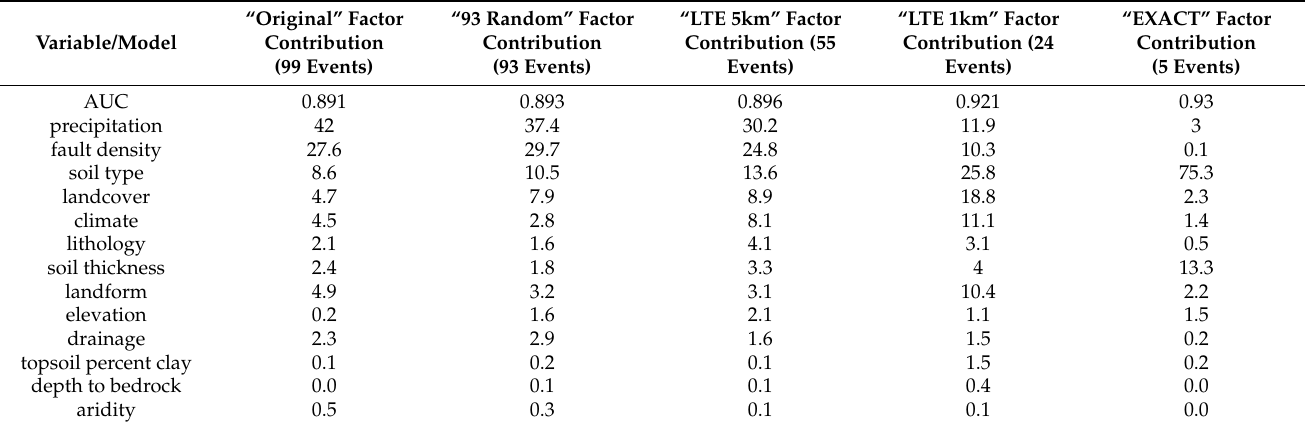
Table 8. AUC and factor contributions (gain) for each of the five MaxEnt